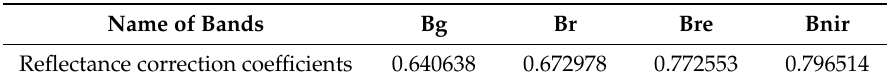
Table 8. Reflectance correction coefficient of S2A.